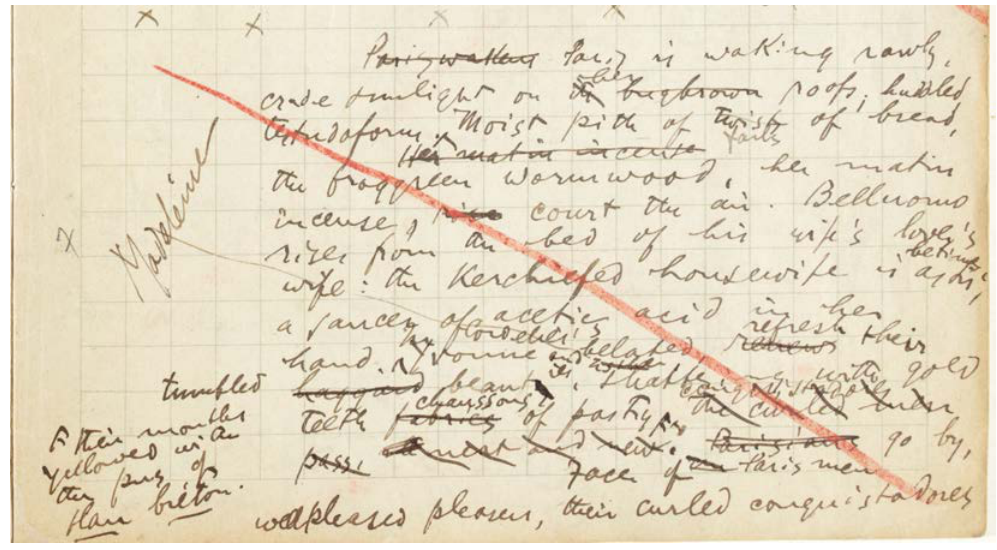
Figure 3 – National Library of Ireland, The Joyce Papers 2002 , II.ii.1.a. Notebook, pre-numbering page [9]